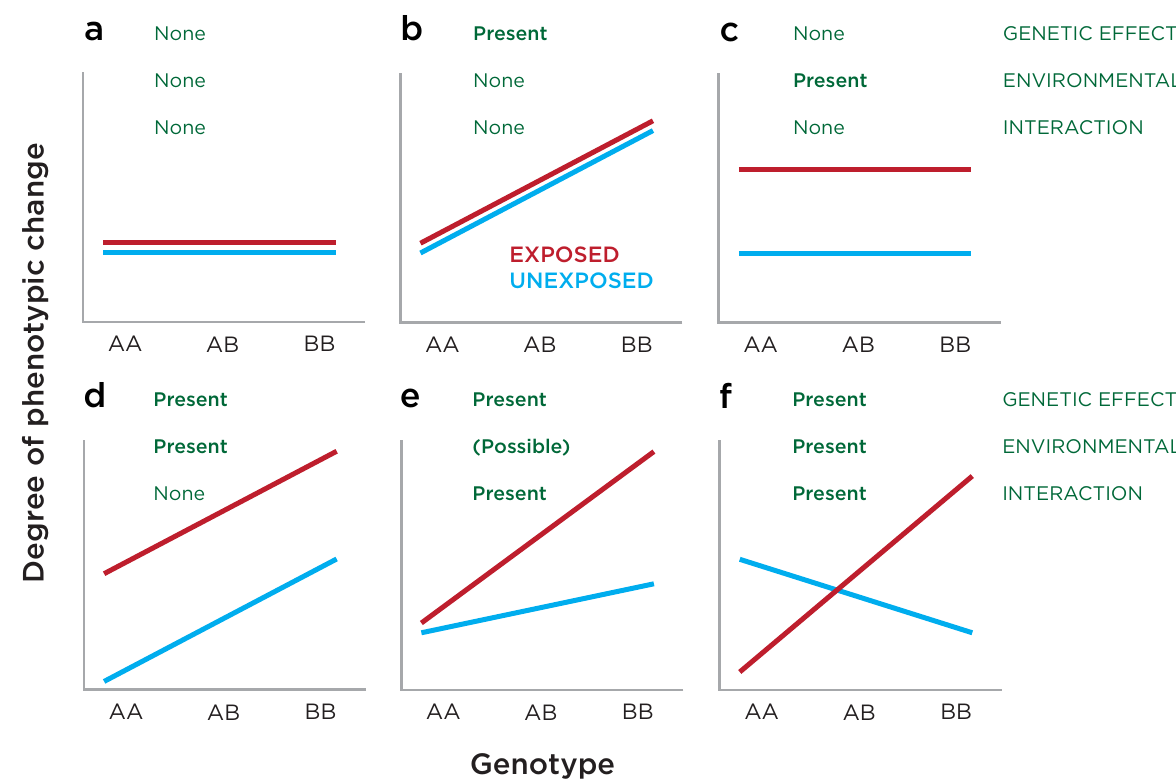
Fig 3. Relating phenotypic change ( y axis) to genotype ( x axis, major allele A and minor allele B) in three situations (green), genetic effects, environmental effects, and interactions.